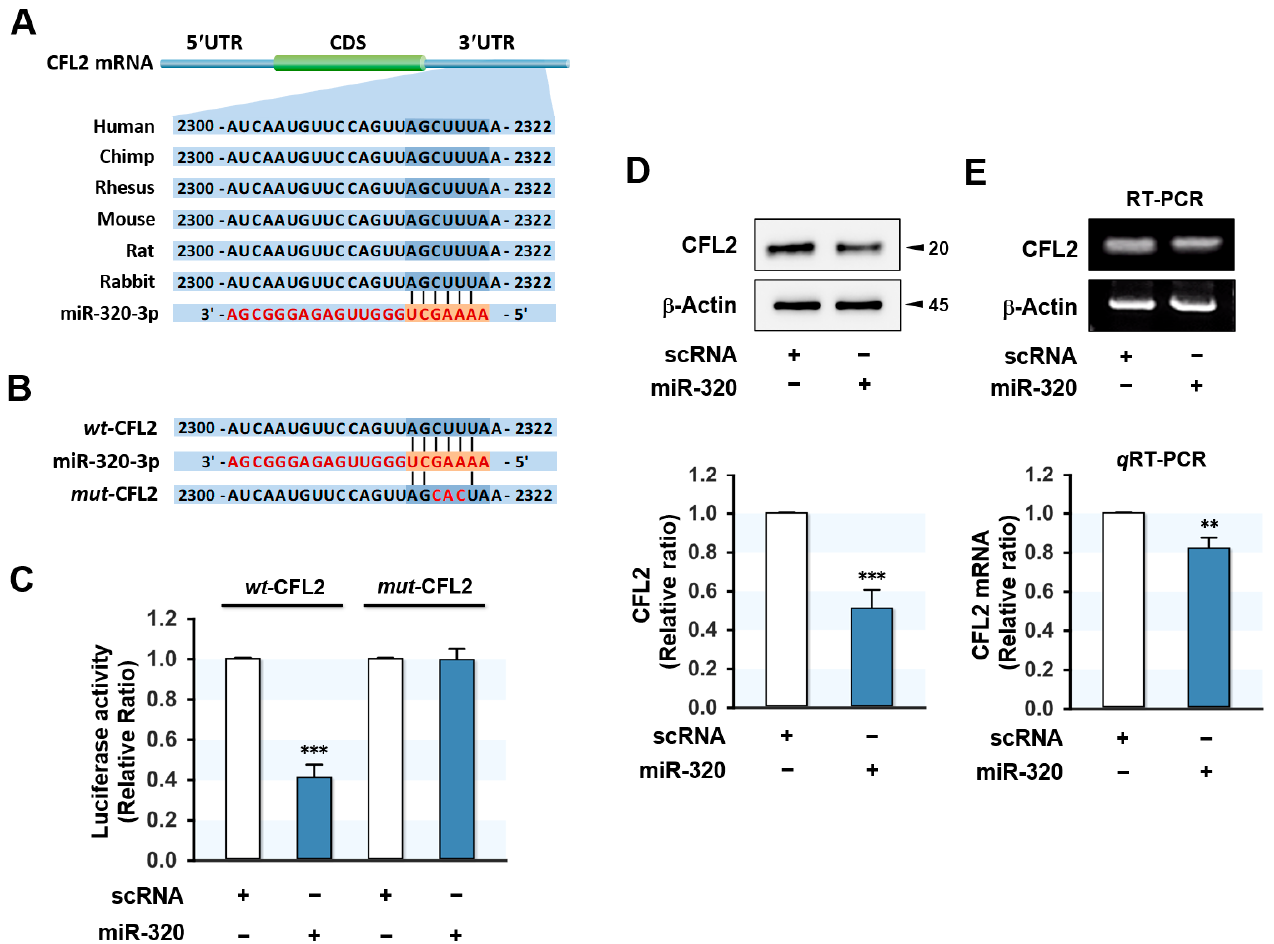
Figure 2. MiR-320-3p downregulated CFL2 expression. ( A ) The conservation of miR-320-3p targeting site in the CFL2 3 ′ UTR. ( B ) The potential binding site for the miR-320-3p seed sequence in the wild-type ( wt -CFL2) or mutant ( mut -CFL2) 3 ′ UTR fragment of CFL2 . ( C ) The relative luciferase activity in myoblasts cotransfected with either wt -CFL2 or mut -CFL2 plasmids and scRNA or miR-320-3p mimic was analyzed 24 h after transfection. ( D ) CFL2 protein expression was determined in myoblasts 24 h after transfection with scRNA or miR-320-3p mimic. The values between panels indicate relative protein levels normalized against β -Actin. ( E ) The mRNA level of CFL2 was analyzed by RT-PCR (upper panel) and q RT-PCR (lower panel), and the values normalized against U6. Results are means ± SEMs ( n > 3). **, p < 0.01; ***, p < 0.001 vs. scRNA control.